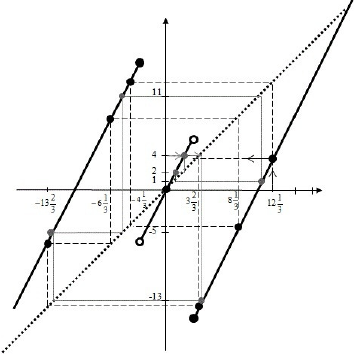
Figure 8. If β = 2, a = 21, α = 3, then by Theorem 7 there exists periodic orbit of period 6: { 12 1